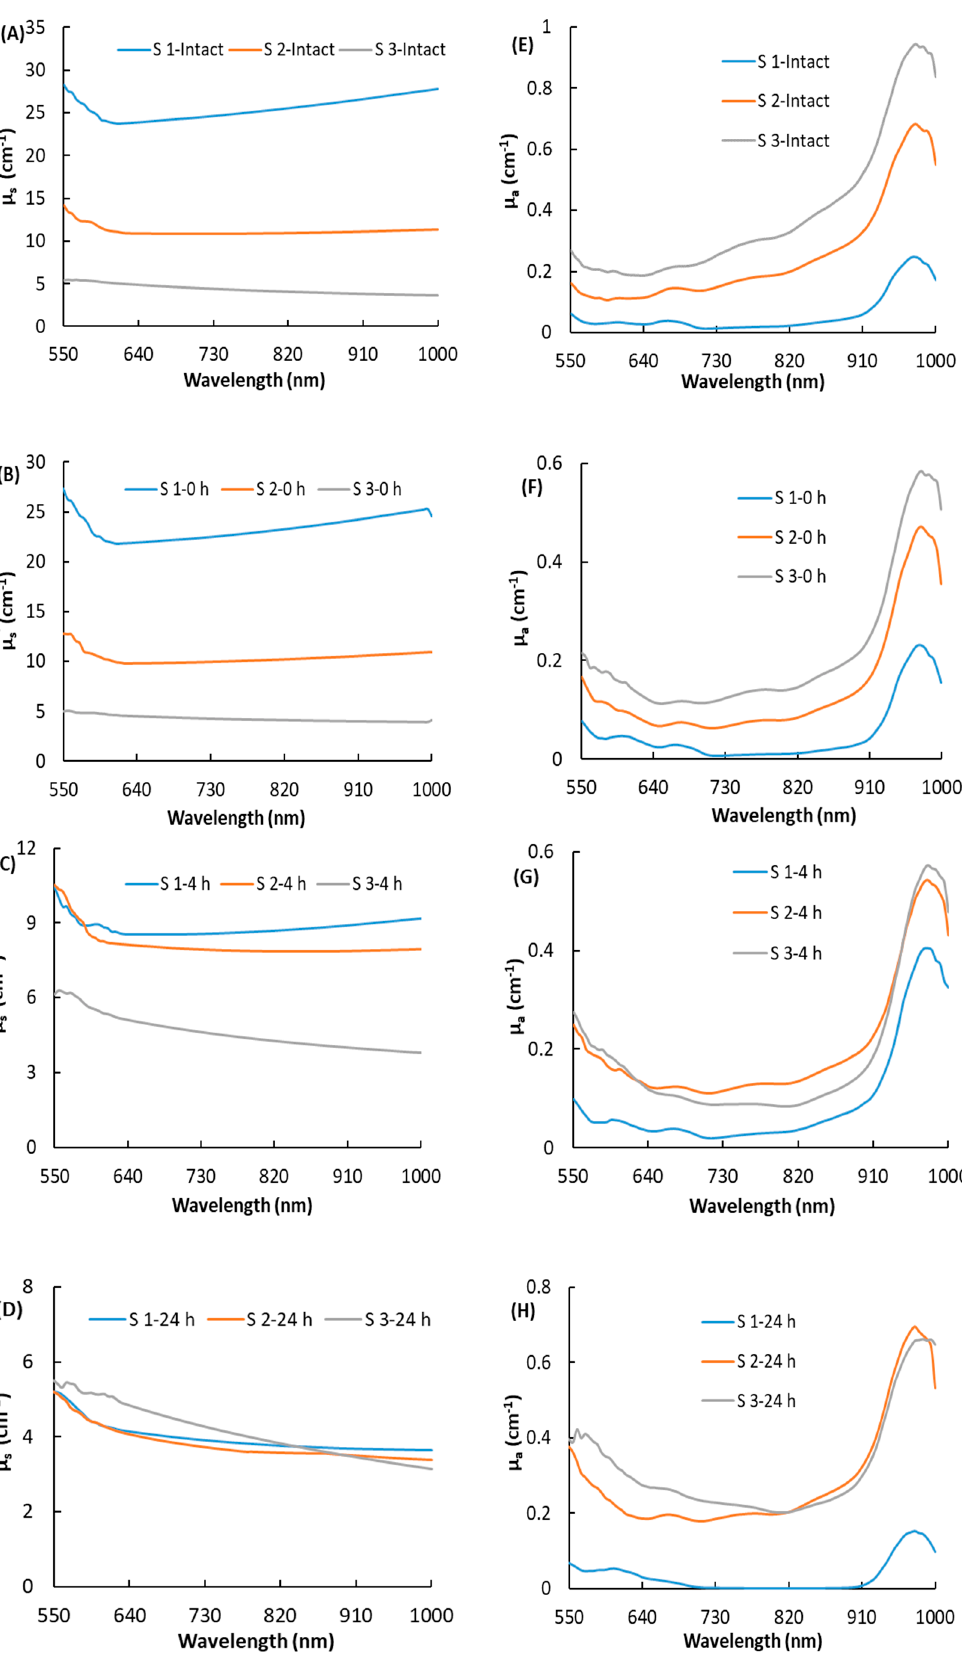
Figure 4. The reduced scattering coefficient ( μ s ’) and the absorption coefficient ( μ a ) of peaches at different maturity stages for health ( A , E ), bruise after 0 h ( B , F ), bruise after 4 h ( C , G ), and bruise after 24 h ( D , H